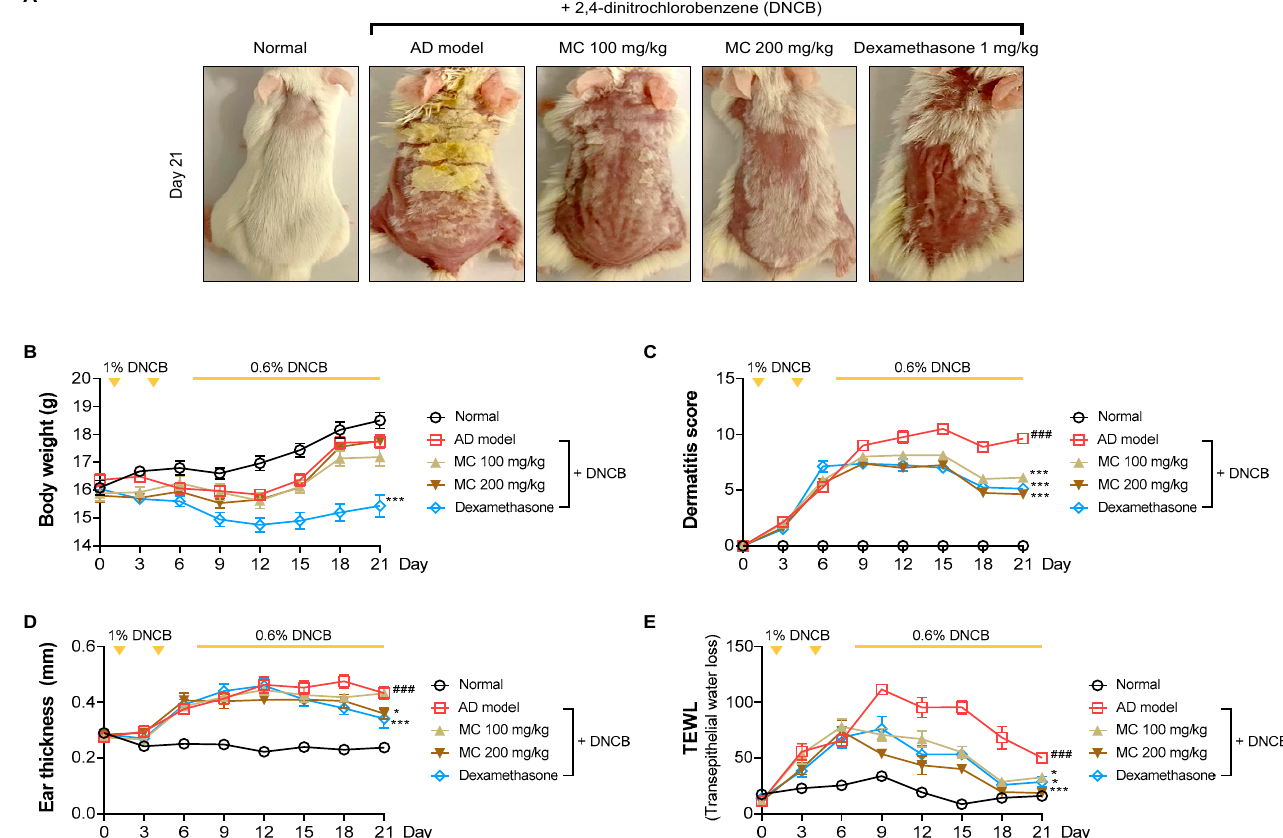
Figure 6. Effects of M. concanensis on atopic dermatitis in BALB/c mice induced by DNCB. The dorsal skin images were obtained at identical magnification, and representative images obtained on day 21 are shown ( A ). The clinical symptoms, including body weight ( B ), dermatitis score ( C ), ear thickness ( D ) and TEWL ( E ), were measured every 3 days (n = 8). The data presented are the mean ± S.E.M. ### p < 0.001 versus Normal. * p < 0.05 and *** p < 0.001 compared to the DNCB-treated group. AD model; only DNCB-treated group, MC 100 mg/kg + DNCB; DNCB-induced mice administered with 100 mg/kg of M. concanensis , MC 200 mg/kg + DNCB; DNCB-induced mice administered with 200 mg/kg of M. concanensis.